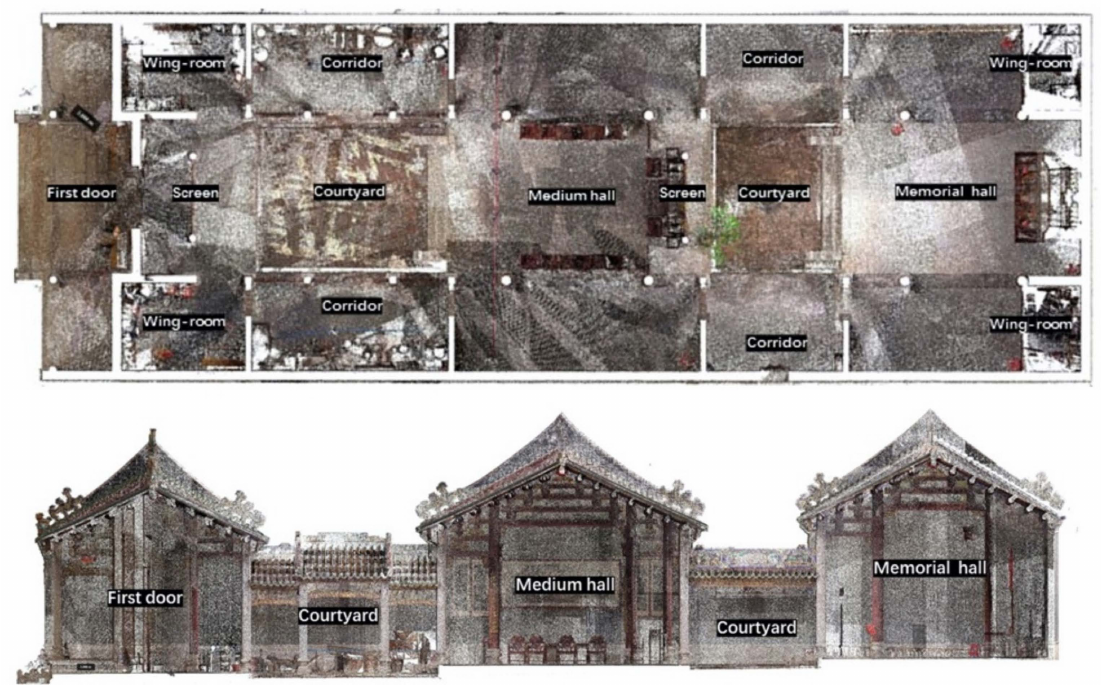
Figure 8. Layout and side view of Wen Ancestral Hall. A top view and a side view the Wen Ancestral Hall are drawn in this figure.